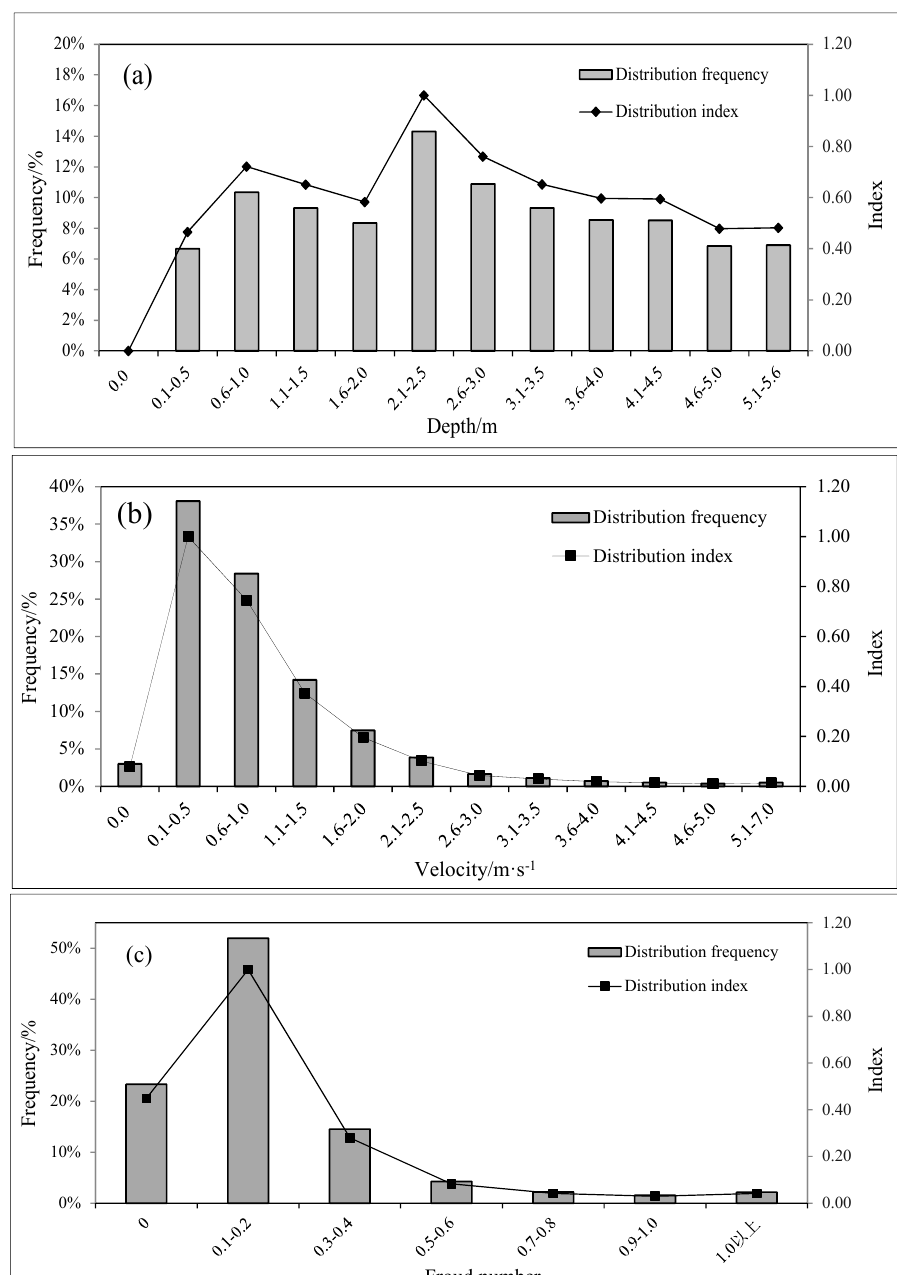
Figure 10. Distribution map of depth ( a ), velocity ( b ), and Froude number ( c ).